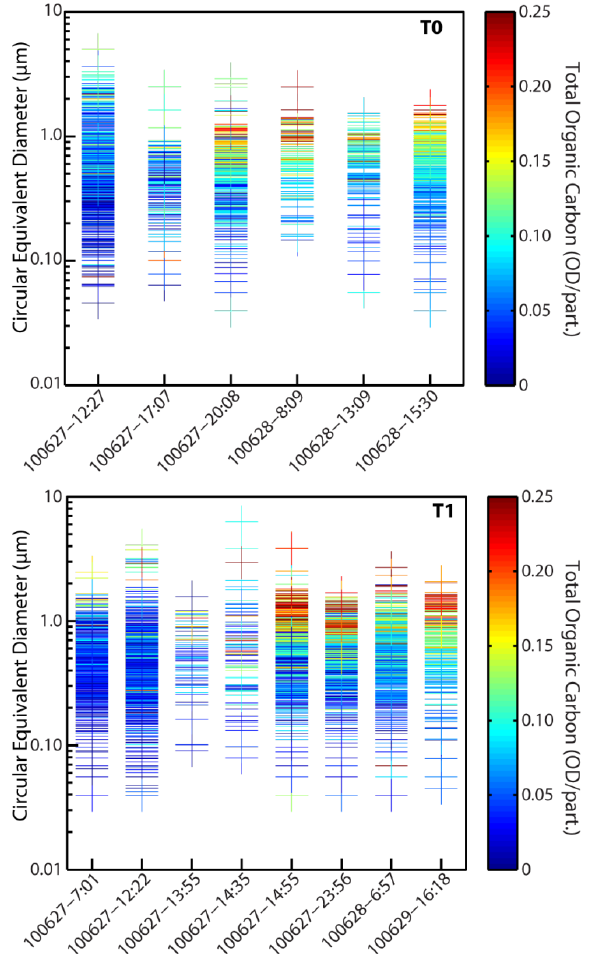
Fig. 8. Size and total organic carbon (color scale) for individual particles (represented as crosses) for the different sampling times at T0 (top) and T1 (bottom). Organic carbon was determined by masking elemental carbon inclusions and averaging over the total carbon remaining in individual particles.